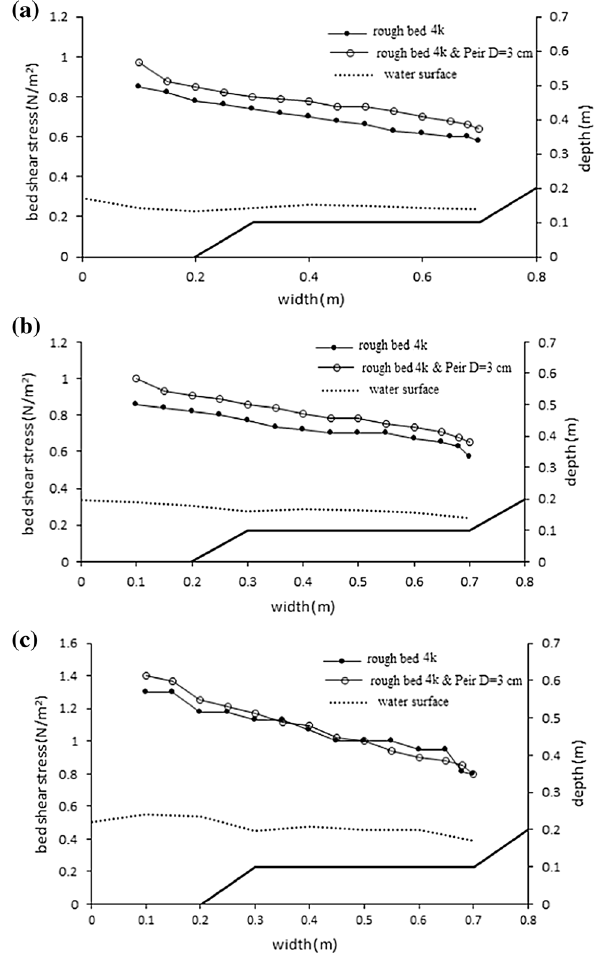
Fig. 9 Comparison of the bed shear stress in a roughened plain with the presence of a pier ( D = 3 cm) and roughened plain (distances